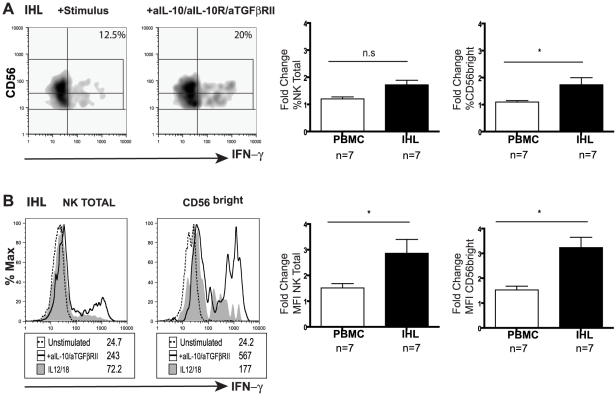
Blockade of IL10/TGF enhances intrahepatic NK cell IFN-γ production.(A) Representative density plots and (B) histograms for total intrahepatic NK cell and CD56bright subset IFN-γ production upon blockade with anti-lL-10, anti-IL10 receptor and anti-TGFβRII blocking antibodies. Paired summary bar charts of fold change increase in the percentage and mean fluorescence intensity (MFI) of NK total and CD56bright IFN-γ+ cells in the periphery and intrahepatic compartment of 7 CHB (median ALT 56). Results are expressed as mean ± SEM. Stimulus  =  IL12+IL18. *p<0.05 by Wilcoxon signed rank test.